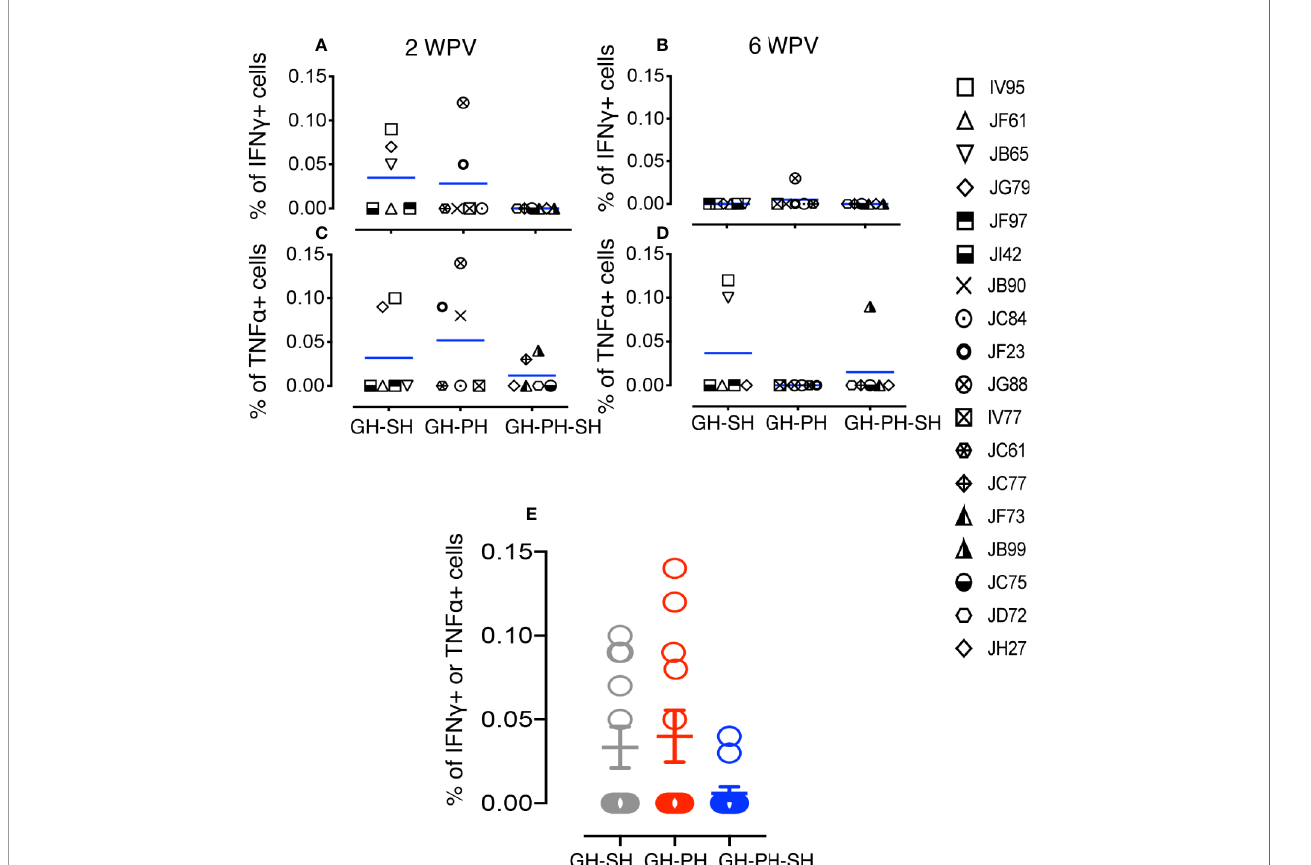
FIGURE 7 | Measles and canine distemper speci fi c CD4 T cell responses in canine distemper and measles vaccinated macaques. Intracellular IFN g responses (A, B) and TNF a responses (C, D) were measured against lysed Canine Distemper measles vaccine (CDMV) at 2 weeks and 6 weeks post-vaccination (WPV) in three different housing groups of macaques. CDMV speci fi c IFN g or TNF a responses in CD4+ T cells were shown for all three groups at 2 WPV with mean ± standard error (E) . Blue lines in (A – D) graphs represent group means for each group. Criteria for a positive cytokine response was a two-fold increase in frequency for measles and canine distemper antigen and cytokine above the medium control culture. All values were subtracted from medium control before